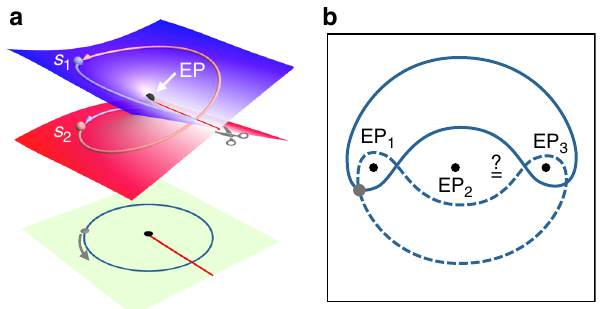
Fig. 1 Different ways of encircling multiple expectational points (EPs). a Illustration of Riemann surface associated with the square root function associated with an archetypal 2 × 2 non-Hermitian Hamiltonian. A loop that encircles the EP (also known as the branch point) starting from the state s 1 will map it onto s 2 and vice versa. In the complex plane projection, this is represented by adding a branch cut as shown by the red line. The gray arrow in the projection plane indicates the encircling direction. b A scenario that exhibits three EPs. In this case, loops can encircle the same EPs in different ways as illustrated by the two loops (solid/dashed lines) that enclose EP 1,3 starting from the same point (gray